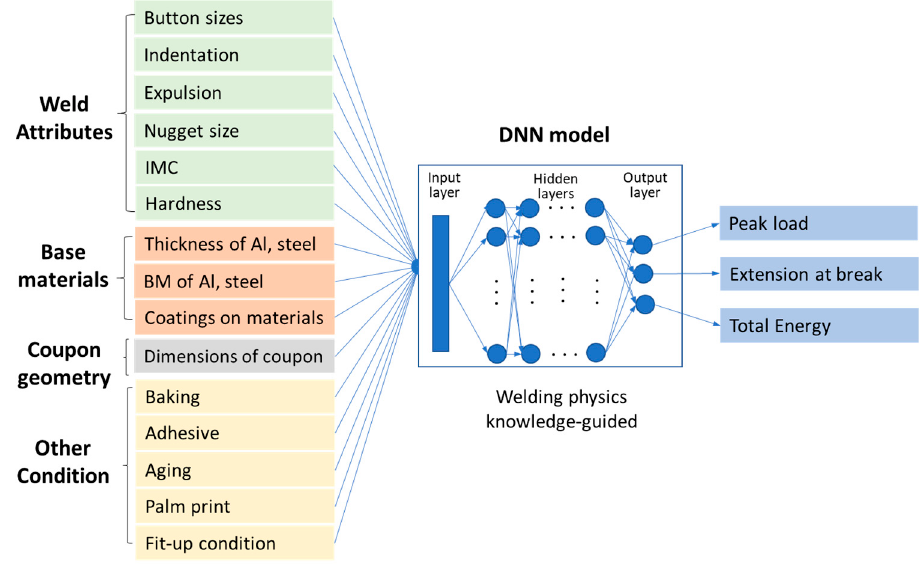
Figure 1. The expandable DNN model with unified neural network architecture for weld attrib- ute—performance